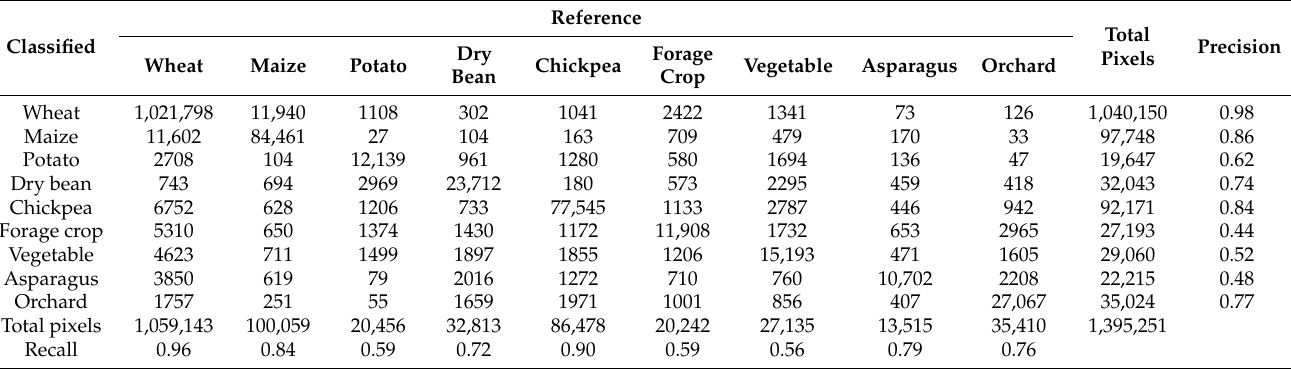
Table 3. Classification matrix resulting from using either 18% of the fields (Ratio-0.18) or 80 fields (Equal-80) of each crop type to train the random forest classifier in Sen2-Agri. The data represent the averages obtained from six classification runs initiated with different random seed numbers. Use of 18% of Fields of Each Crop Type for Training